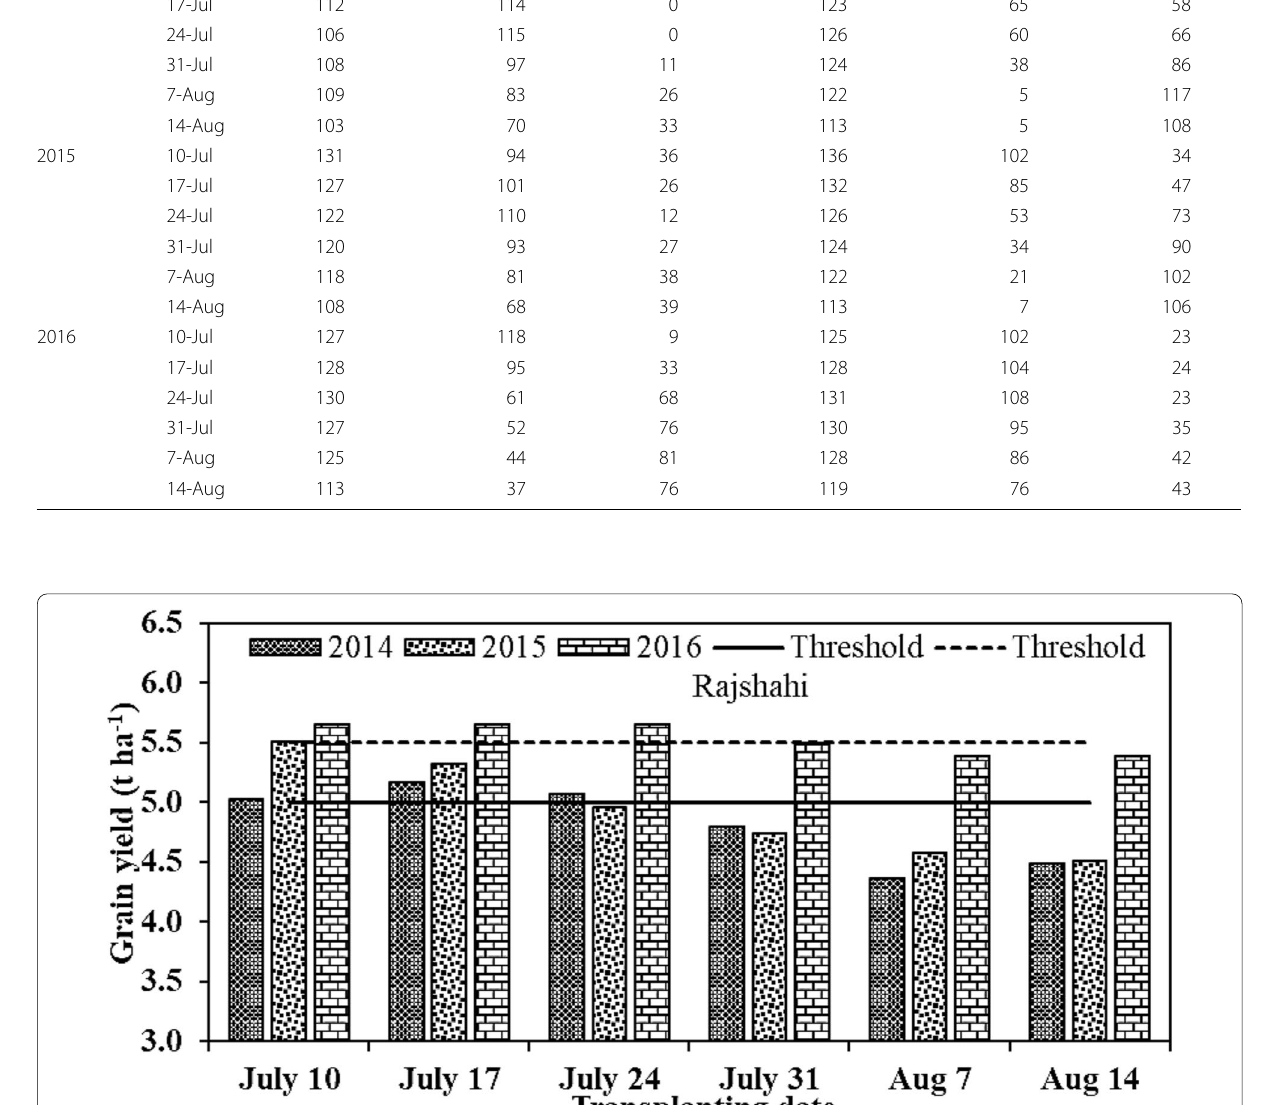
solar radiation, carbon di oxide concentration etc. can be incorporated for future study. A policy level study can be executed to estimate the yield advantage from recommended transplanting window to national rice production.